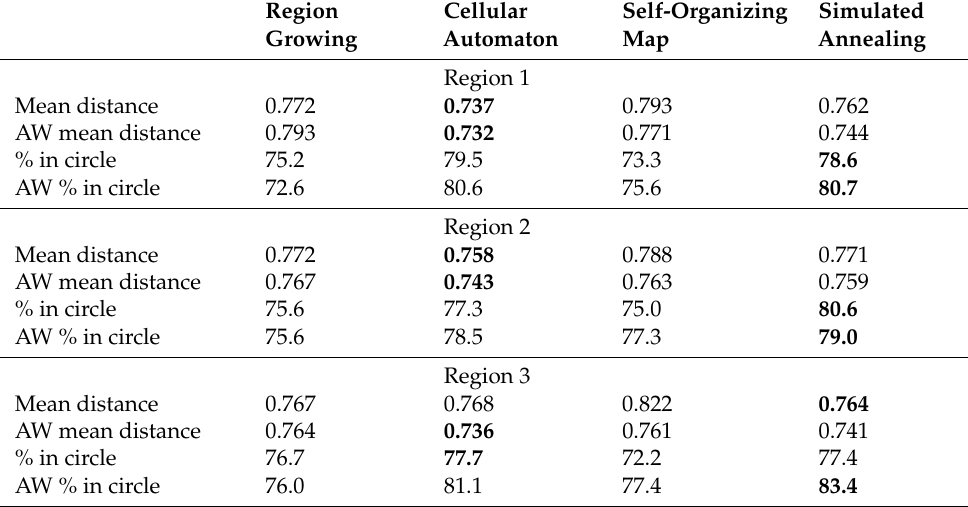
Table 4. Statistics related to the shape of segments. The method with the best value of the statistic is in boldface. AW stands for “area-weighted” and means that the average value of the statistic among the segments was calculated using segment area as the weight. Region Cellular Self-Organizing Growing Automaton Map